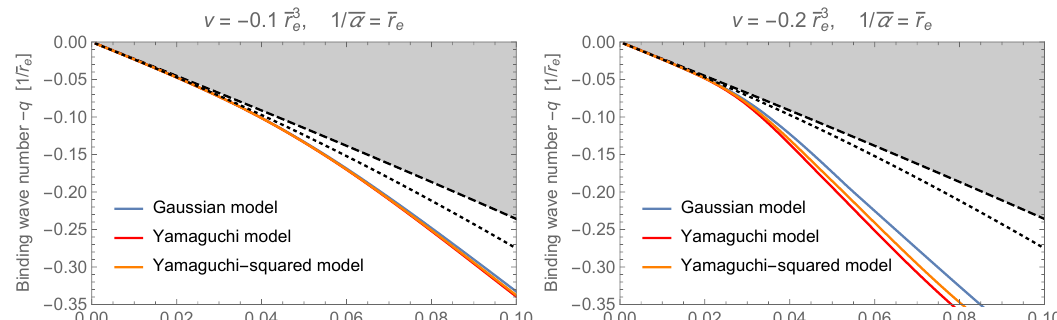
Figure 5: Similar plots to the left panel of Fig. 2 in presence of a weak attraction between the fermions using the models of Table 2 of Appendix 1. Left: the scattering volume is set to v = − 0.1¯ r 3 ; Right: plot for v = − 0.2¯ r 3 . Dashed curve: limit of e e the fermion-particle dimer continuum; Dotted curve: s-wave induced trimer without fermion-fermion interaction ( v = 0) for the Gaussian model, corresponding to the blue curve of Fig.